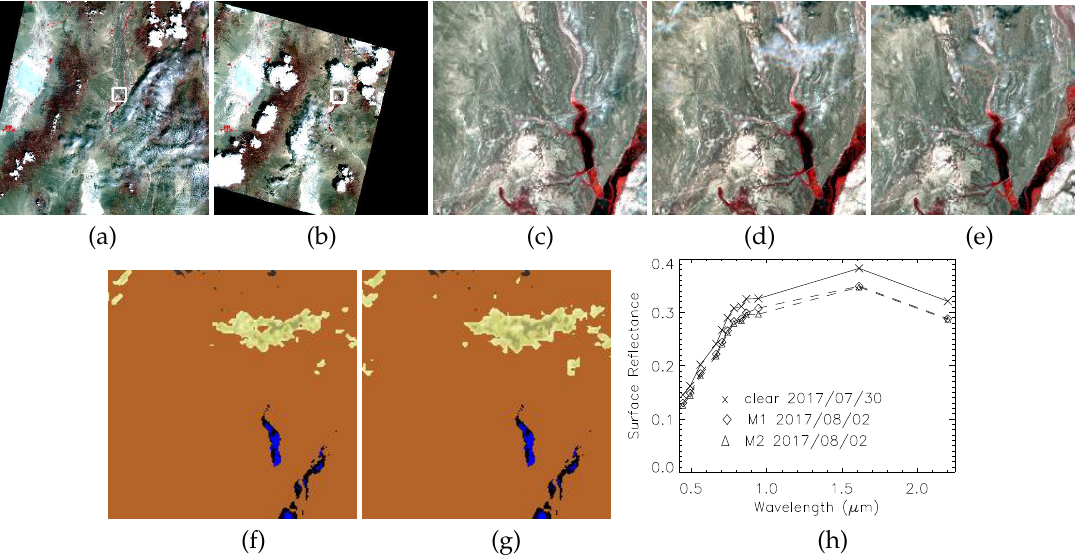
Figure 8. Sentinel-2 Railroad Valley, CIR rendition, ( a ) 30/07/2017; ( b ) 02/08/2017; ( c ) white box subset of ( a ); ( d ) white box subset of ( b ); ( e ) cirrus removal with method M2 (visually very similar to M1); ( f ) subset M1 cirrus mask; ( g ) M2 cirrus mask (same color coding as in Figure 2); ( h )